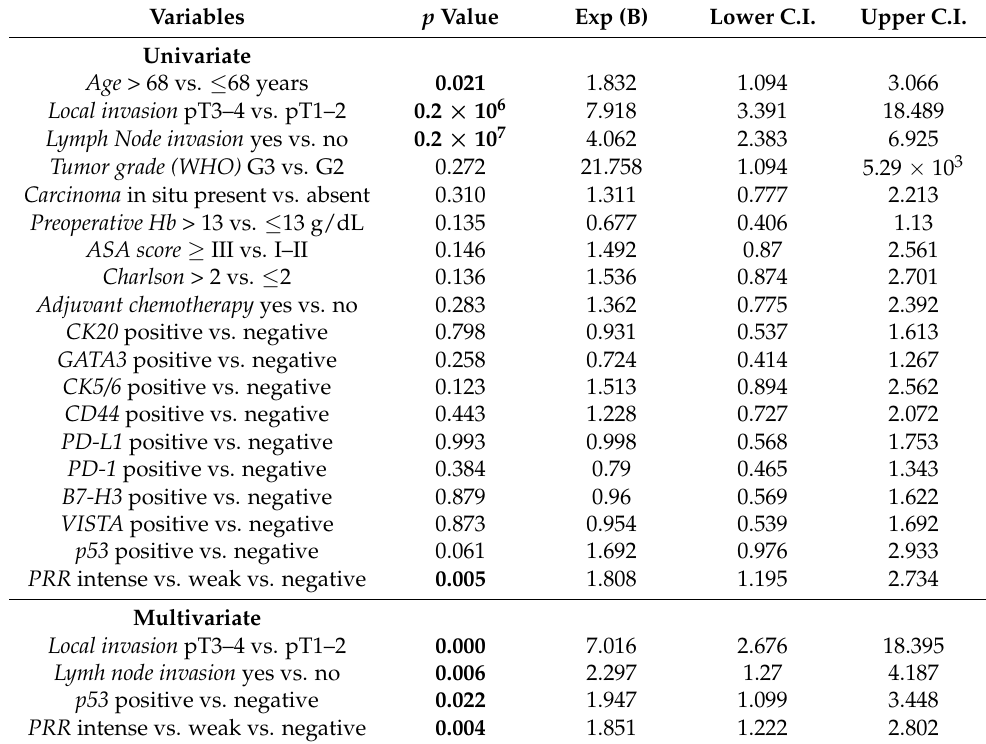
Table 4. Cox regression model for cancer-specific survival prediction stepwise model with p = 0.1 in this series; statistically significant values highlighted in bold.